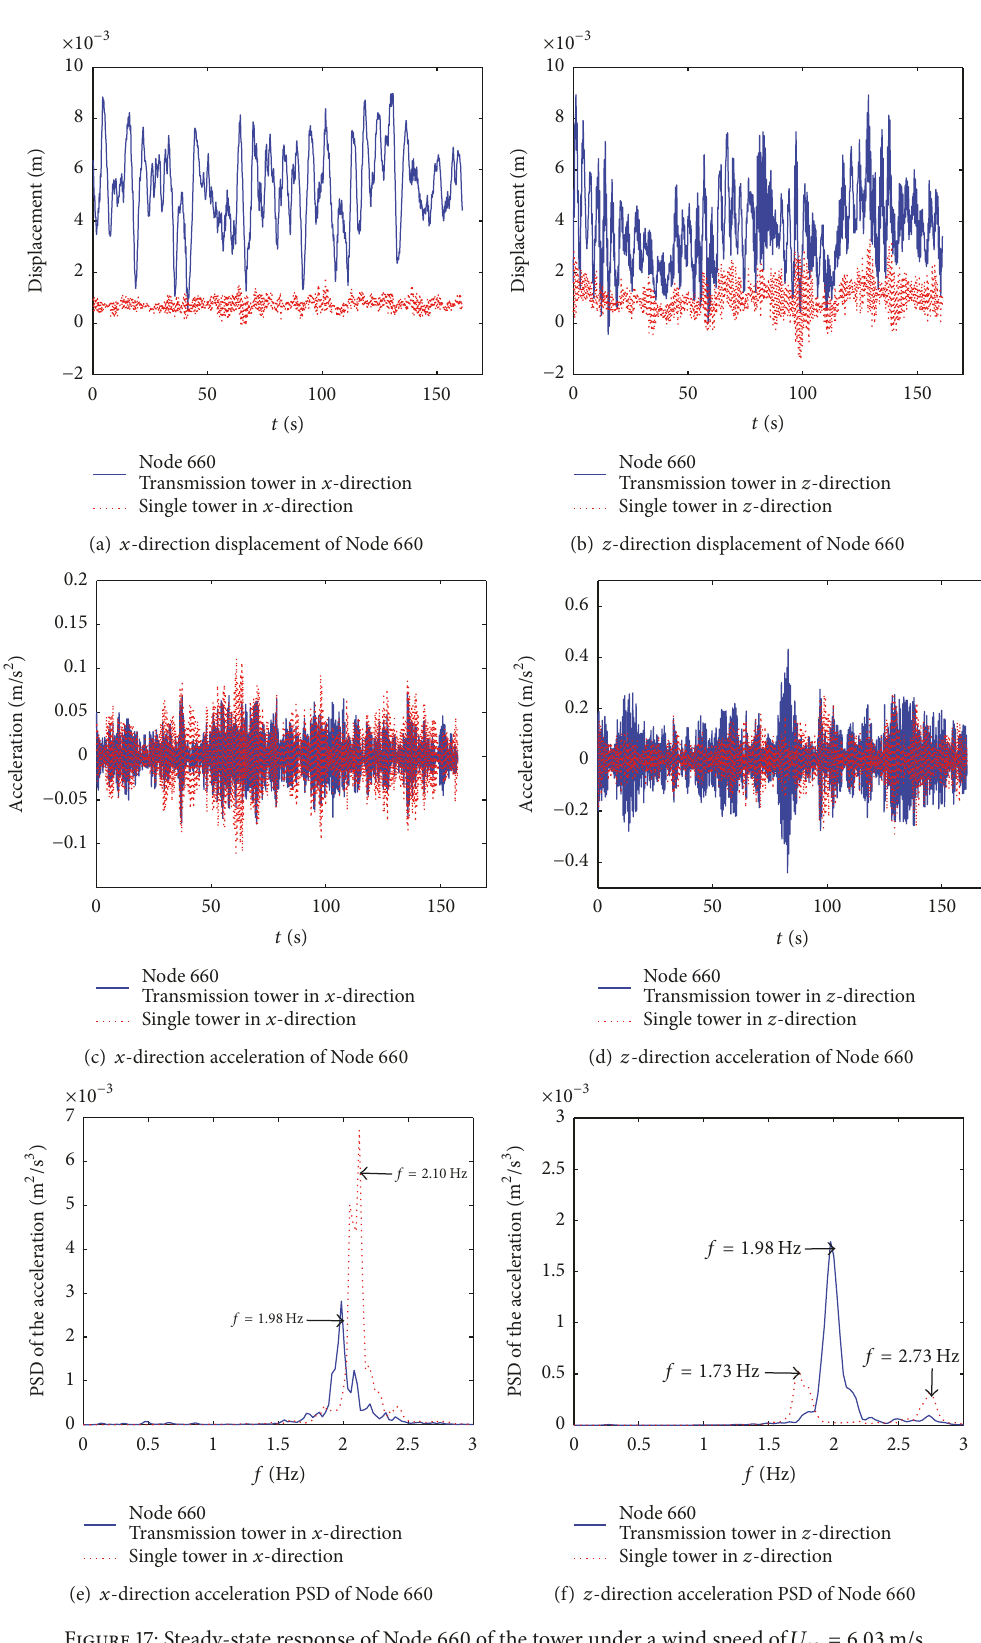
Figure 17: Steady-state response of Node 660 of the tower under a wind speed of 𝑈 10 = 6.03